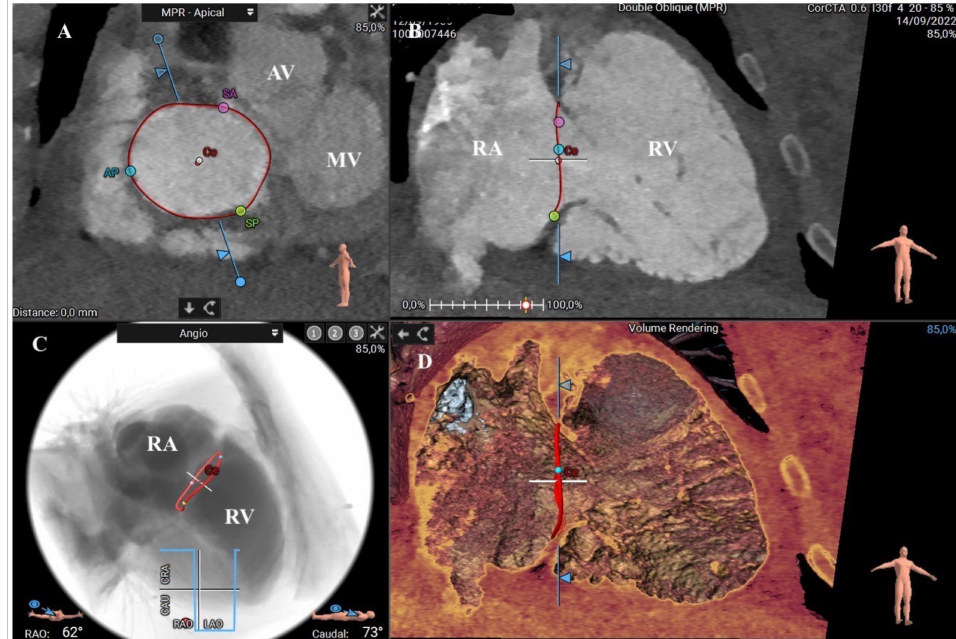
Figure 11. CT assessment of the tricuspid annulus using a semiautomated software-based approach (3mensio Structural Heart; Pie Medical Imaging, Maastricht, The Netherlands): ( A ) Transverse plane (short-axis) at level of tricuspid annulus that is delineated by the red line. The centroid of the tricuspid valve (Ce) and the three main commissures (SA: septal anterior, SP: septal posterior, AP: anteropos- terior) are identified according to specific anatomical landmarks. ( B ) Coronal plane (long axis) at level of the anteroposterior diameter of the tricuspid annulus. ( C ) Fluoroscopic and angiographic simulation showing the three-dimensional position of the tricuspid annulus and commissures within the right heart chambers. ( D ) Three-dimensional recontraction by the volume rendering of the right chambers showing the geometrical spatial relationship of the tricuspid annulus and surrounding structures. RA: right atrium; RV: right ventricle; MV: mitral valve; AV: aortic